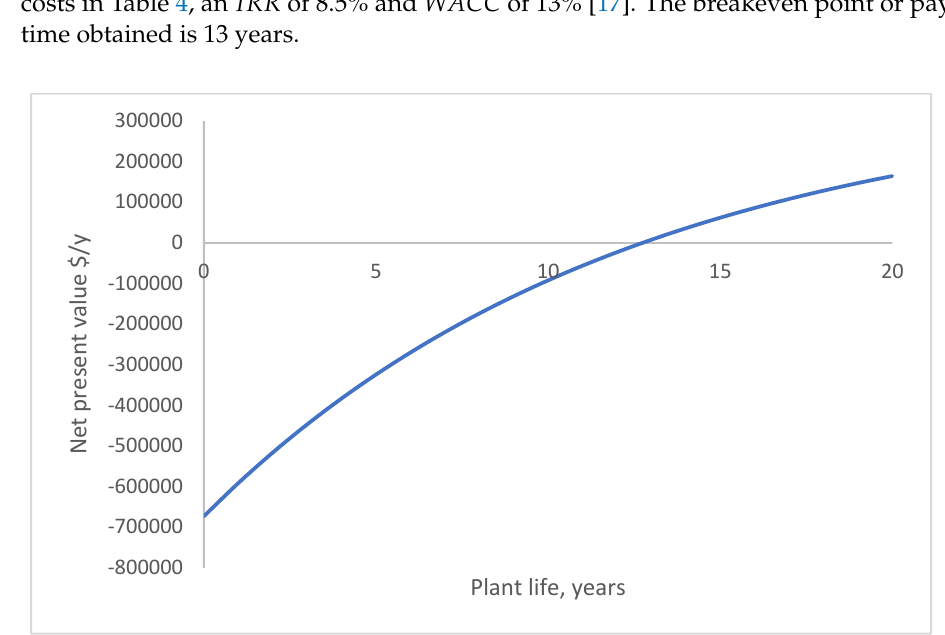
Figure 4. Net present value analysis for the calculated capital and operating costs in Table 4, an 𝐼𝑅𝑅 of 8.5% and 𝑊𝐴𝐶𝐶 of 13%. and 𝐶𝑎𝑝𝑒𝑥 and the product throughput per year, is 433 USD/t.